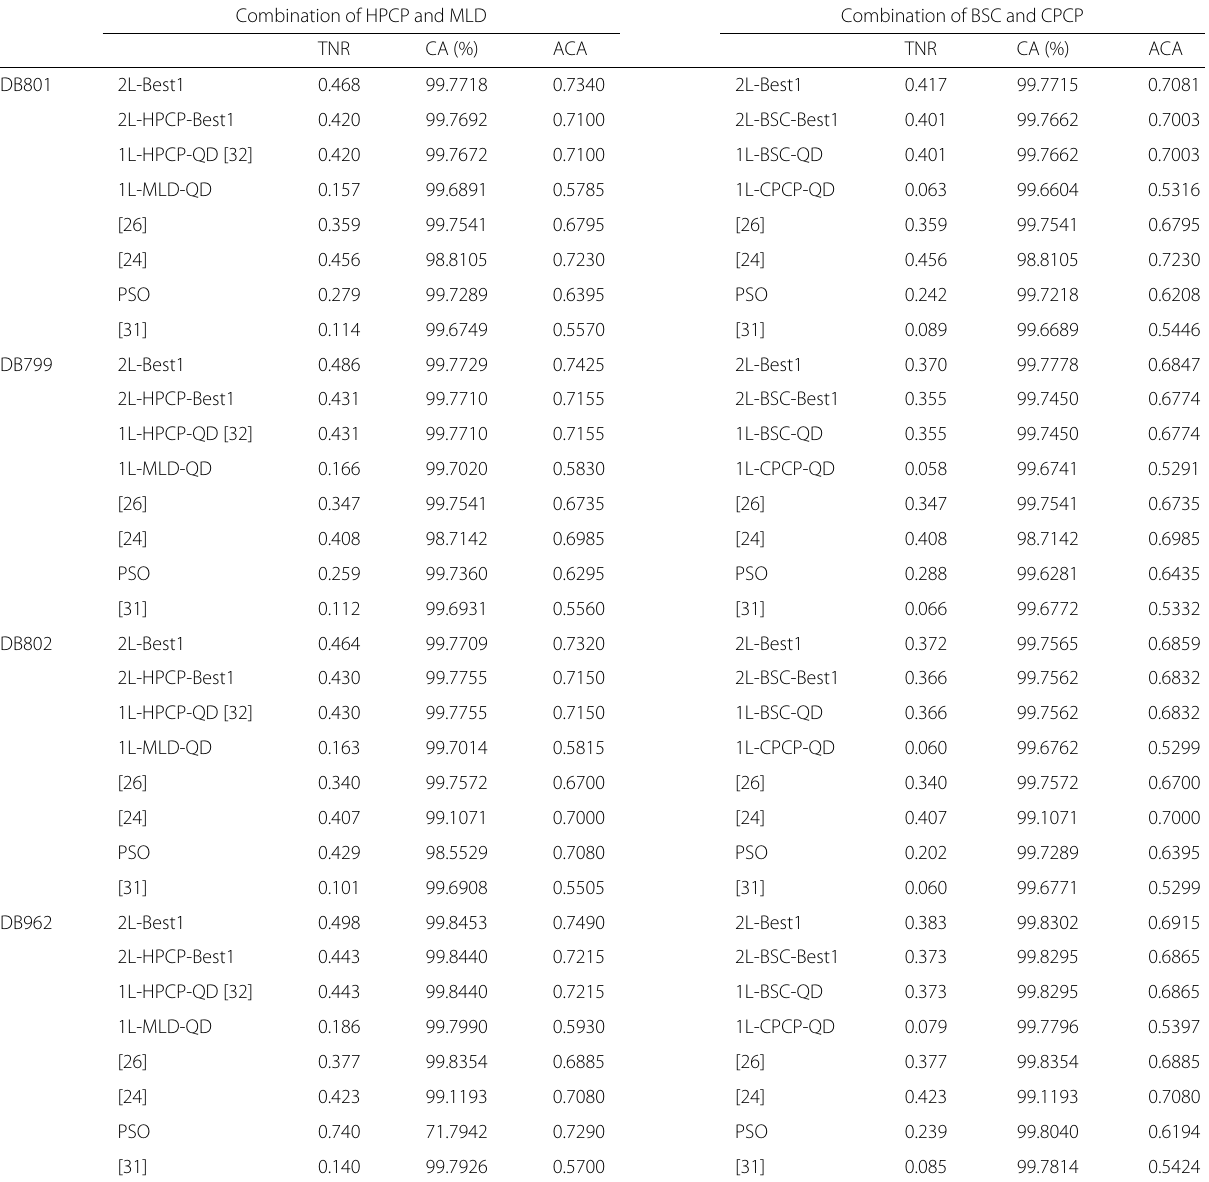
Table 6 Classification efficiency achieved by different descriptor combinations Combination of HPCP and